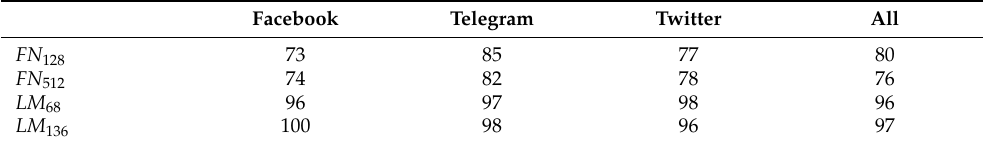
Table 12. Accuracy of the different classifiers (SVM model) on a subset of the TrueFace dataset, including images shared through different social media platforms (reported in